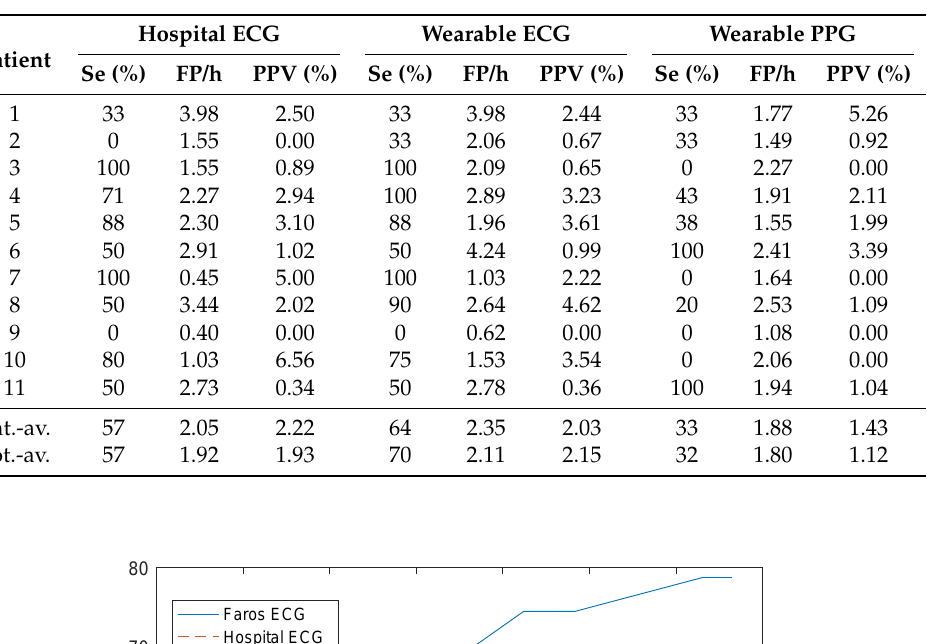
Table 2. Seizure performance: The sensitivities (Se), false positives per hour (FP/h) and positive predictive value (PPV) are shown with the patient average (Pat.-av.) and total average (Tot.-av.).